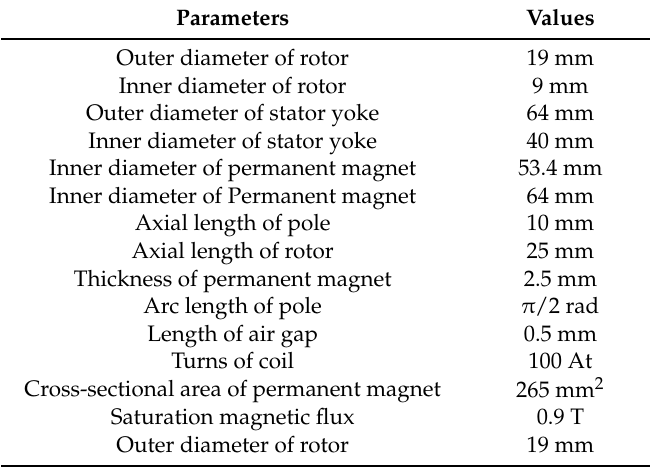
Table 1. Specifications of the three-pole radial HMB.